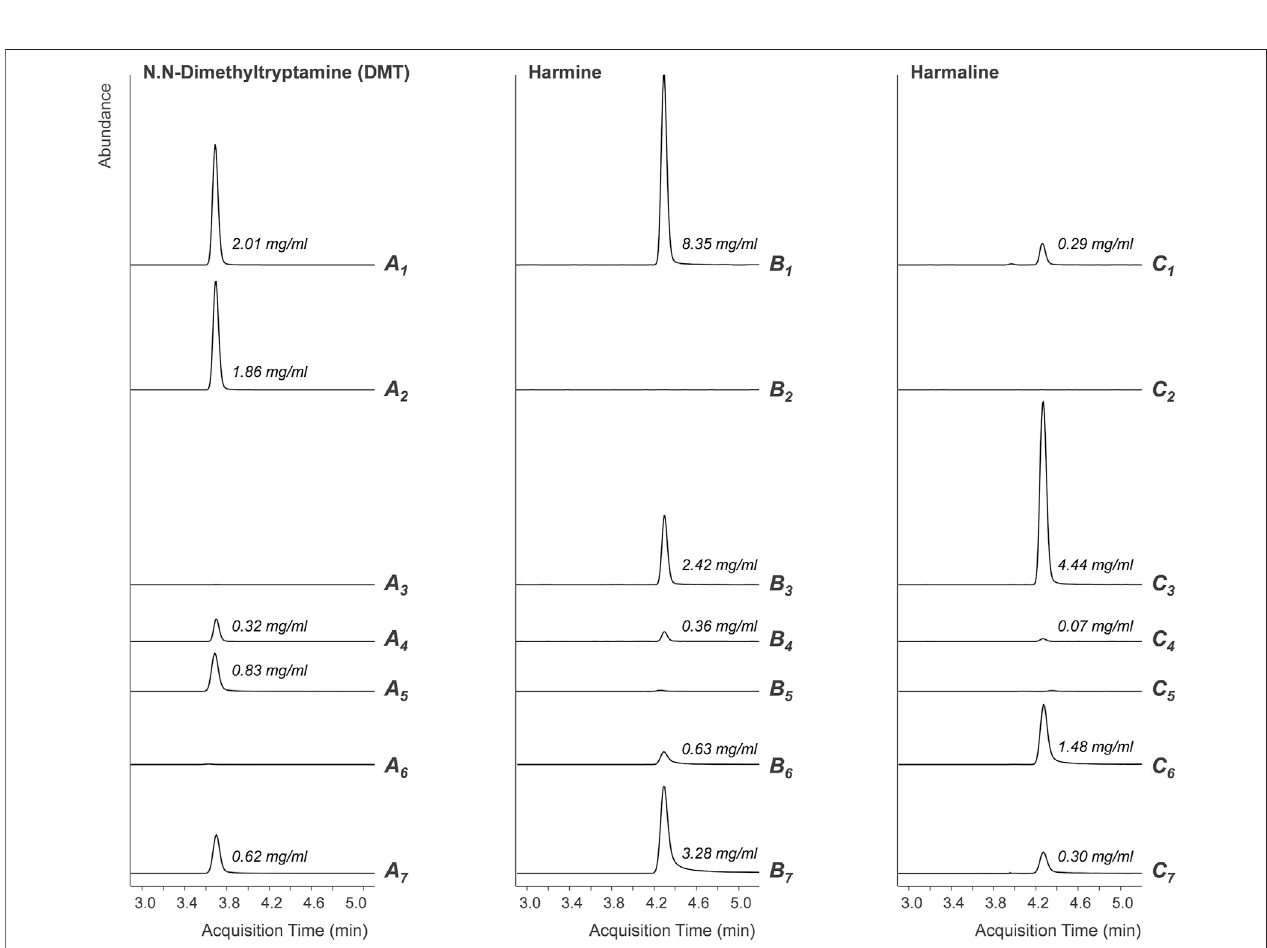
FIGURE 2 | Extracted ion chromatograms of LC-MS analyses of the ayahuasca ’ s active ingredients DMT (A) , harmine (B) and harmaline (C) in the preparations usedinLocation1(index1),Location2(consistingofMimosahostilis,index2,andPeganumharmala,index3),Location3(index4)andLocation4(consistingofMimosa hostilis, index 5, Peganum harmala, index 6, and a preparation of Banisteriopsis muricata, index 7). The abundances of the analytical signals are equally scaled for each analyte and the concentrations in the brews are annotated.